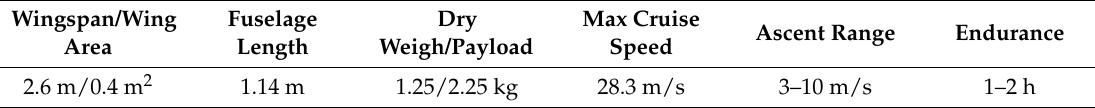
Figure 1 . OVLI-TA UAV ( a , b ) based on the commercial airborne model Techpod, manufactured by HobbyUAV. Table 1. Technical characteristics of OVLI-TA.